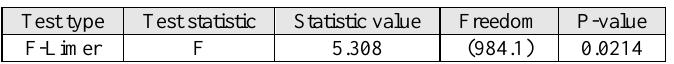
Table 7: Results of Wald Test for model